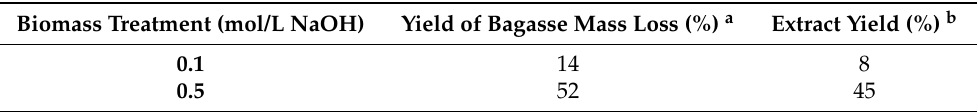
Table 1. Analysis of alkaline hydrolysis solution of sugar cane bagasse.